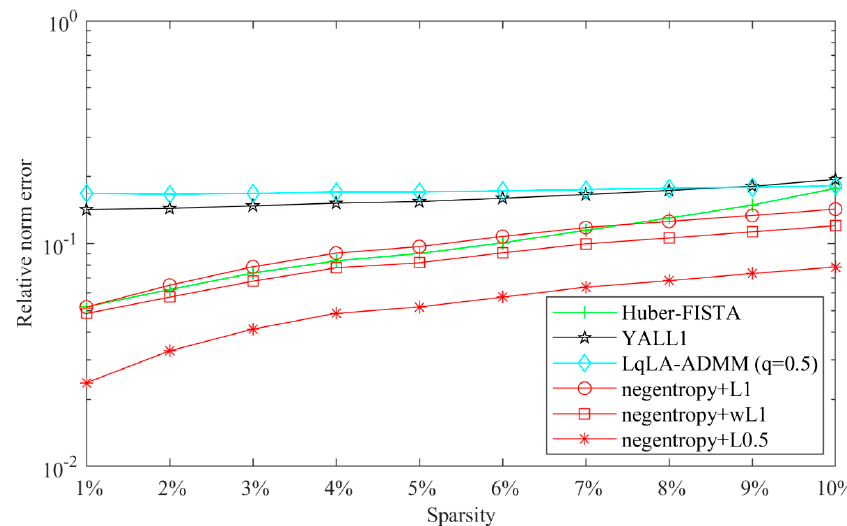
Figure 10. Relative norm error performance versus sparsity.